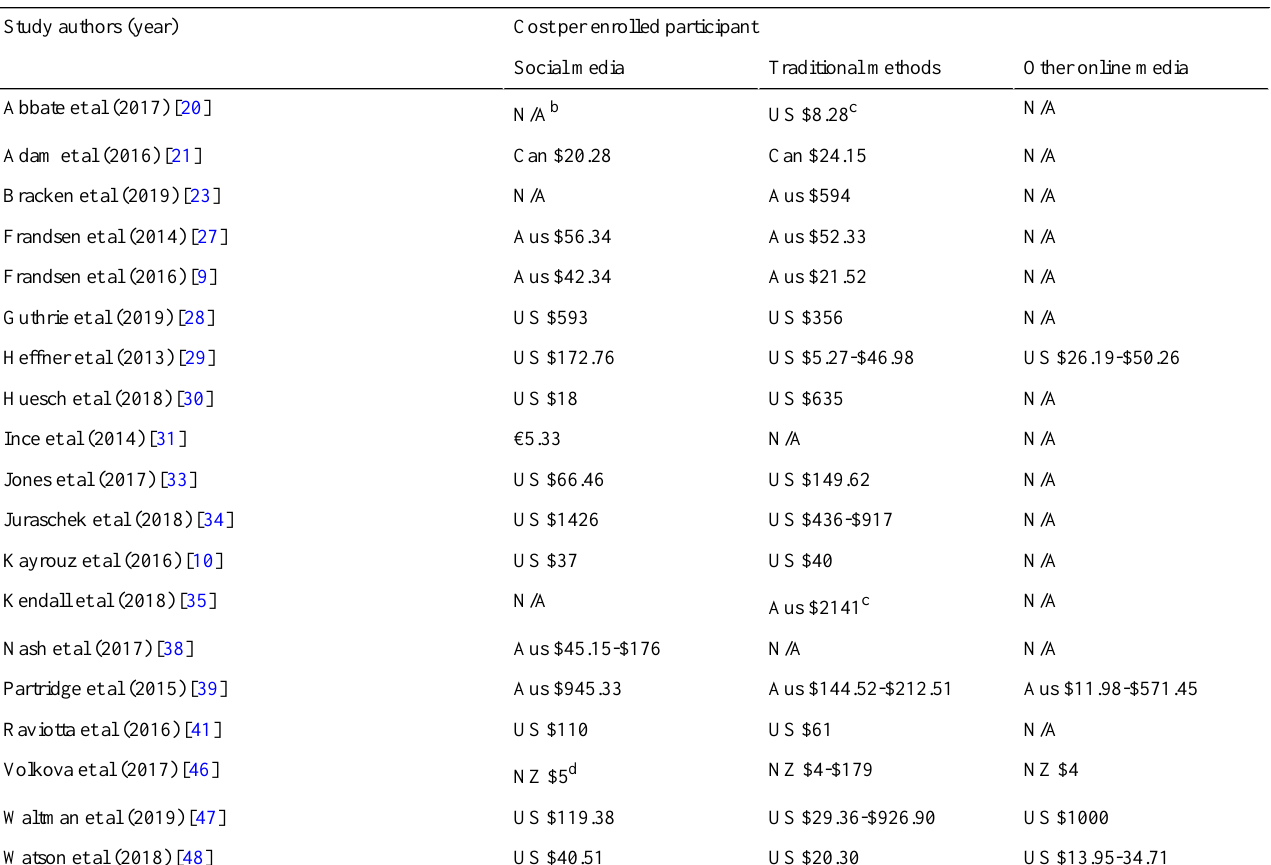
Table 5. Costs per enrolled participant by media type. a